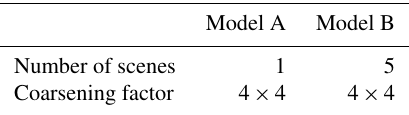
Table 2. Data used to train each of the models for Sect. 4.2. Model A learns from a single cloud generator scene, whereas model B learns from five generator